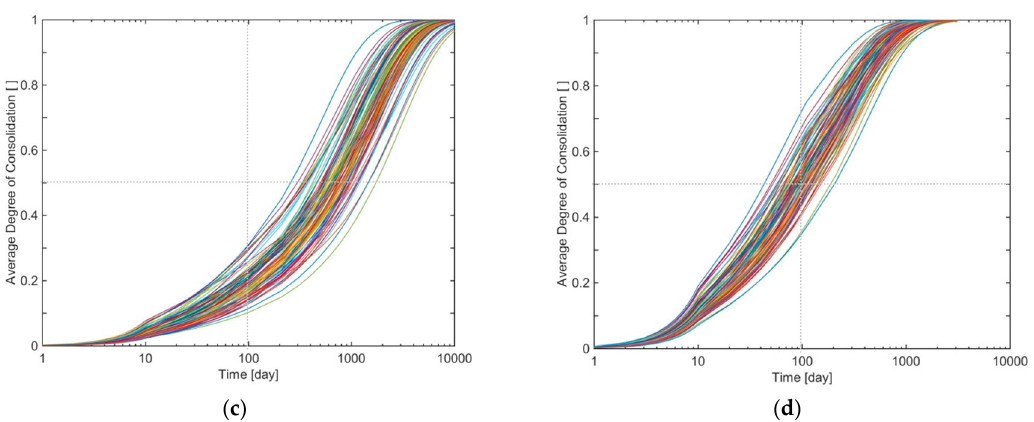
Figure 6. Selected simulation results with spatially varying hydraulic conductivity COV[k], and drainage conditions. The 100 realizations are generated with the given correlation length ( Θ = 0.1); ( a ) COV[k] = 0.4, No Vertical Drain; ( b ) COV[k] = 0.4, Vertical Drain Installed; ( c ) COV[k] = 0.8, No Vertical Drain; ( d ) COV[k] = 0.8, Vertical Drain Installed.